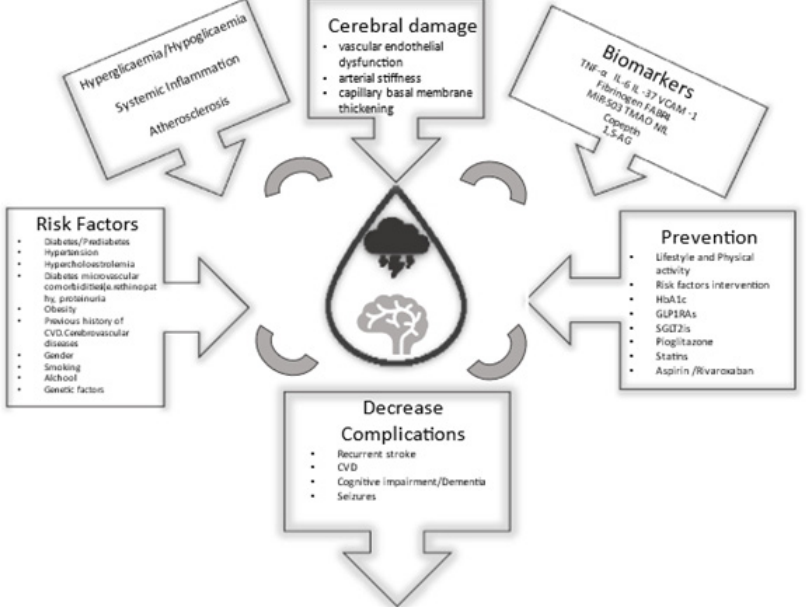
Figure 2. Stroke and diabetes risk factors, pathophysiology, complications and prevention for stroke promoted by diabe- tes.